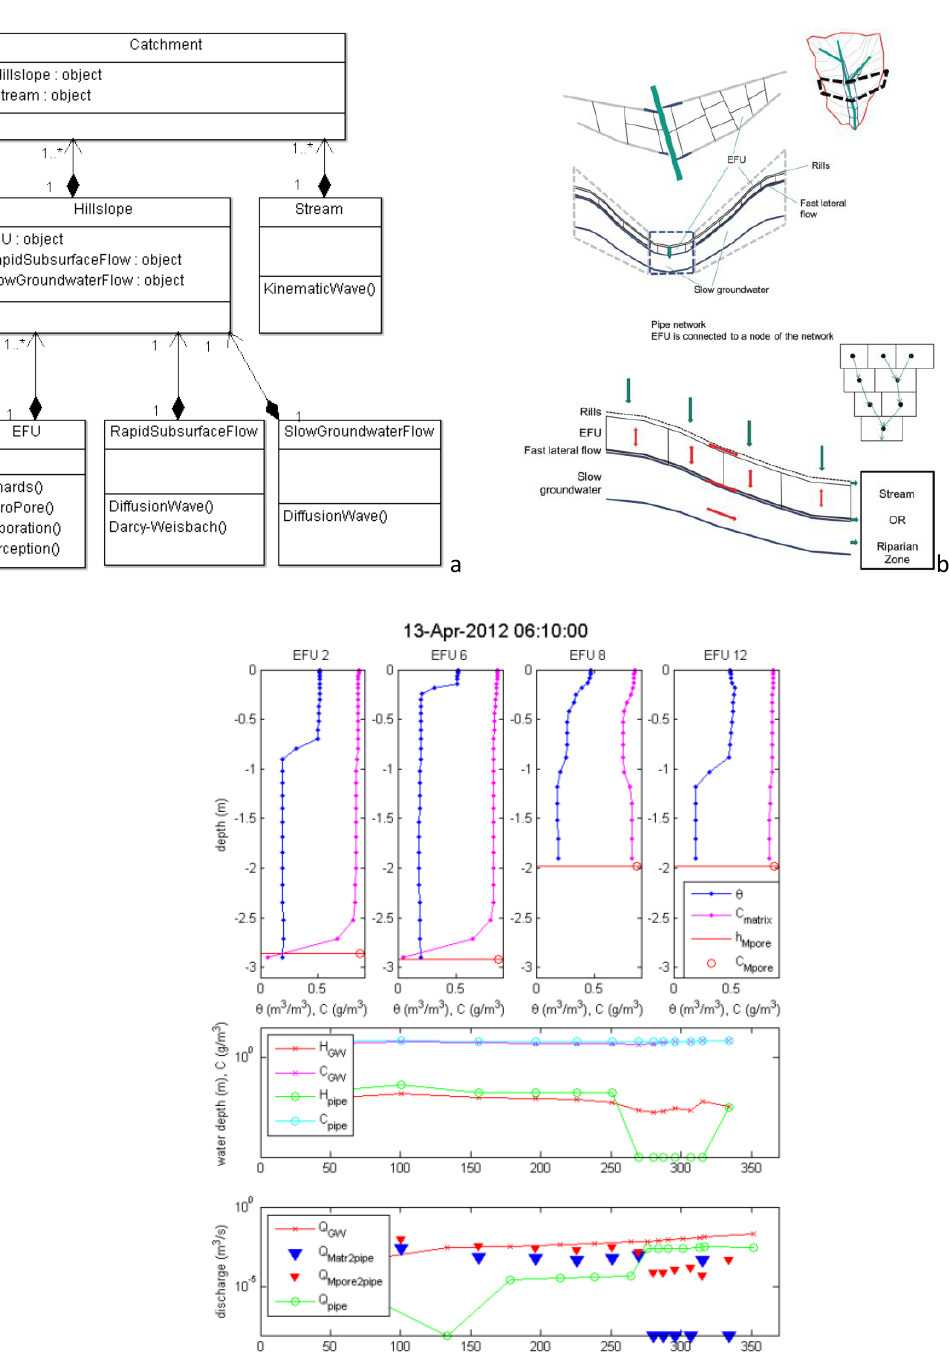
Figure 3. (a) Simplified UML diagram of the current CAOS model structure. Each object either has child objects or solves 1-D flux equations. (b) Sketch of the physical model elements. (c) Exemplary visualization of model states and output: top panels show EFU soil moisture profiles and tracer concentrations, middle panel shows water levels and tracer concentration in fast and slow lateral flow domains, lower panel shows discharge from soil matrix and macropores into pipes as well as along the lateral flow domains. Numerical solutions have mass relative balance errors of order 0.001 to 0.01.